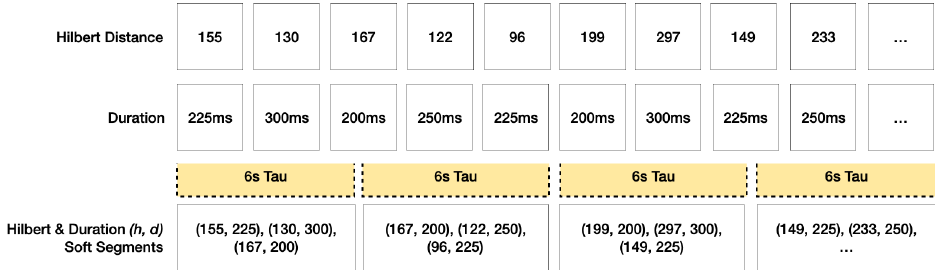
Figure 5. This example illustrates how fixation points, converted from ( x , y ) coordinates into ( h ) Hilbert distances, are binned using a tau τ window of 6 s. Each Soft segment, i.e., 6 s tau window, consists of a set of Hilbert and duration ( h , d )